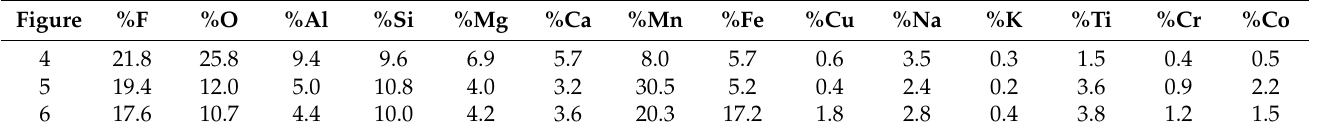
Table 5. Average EDX analyses of 3D slag in Figures